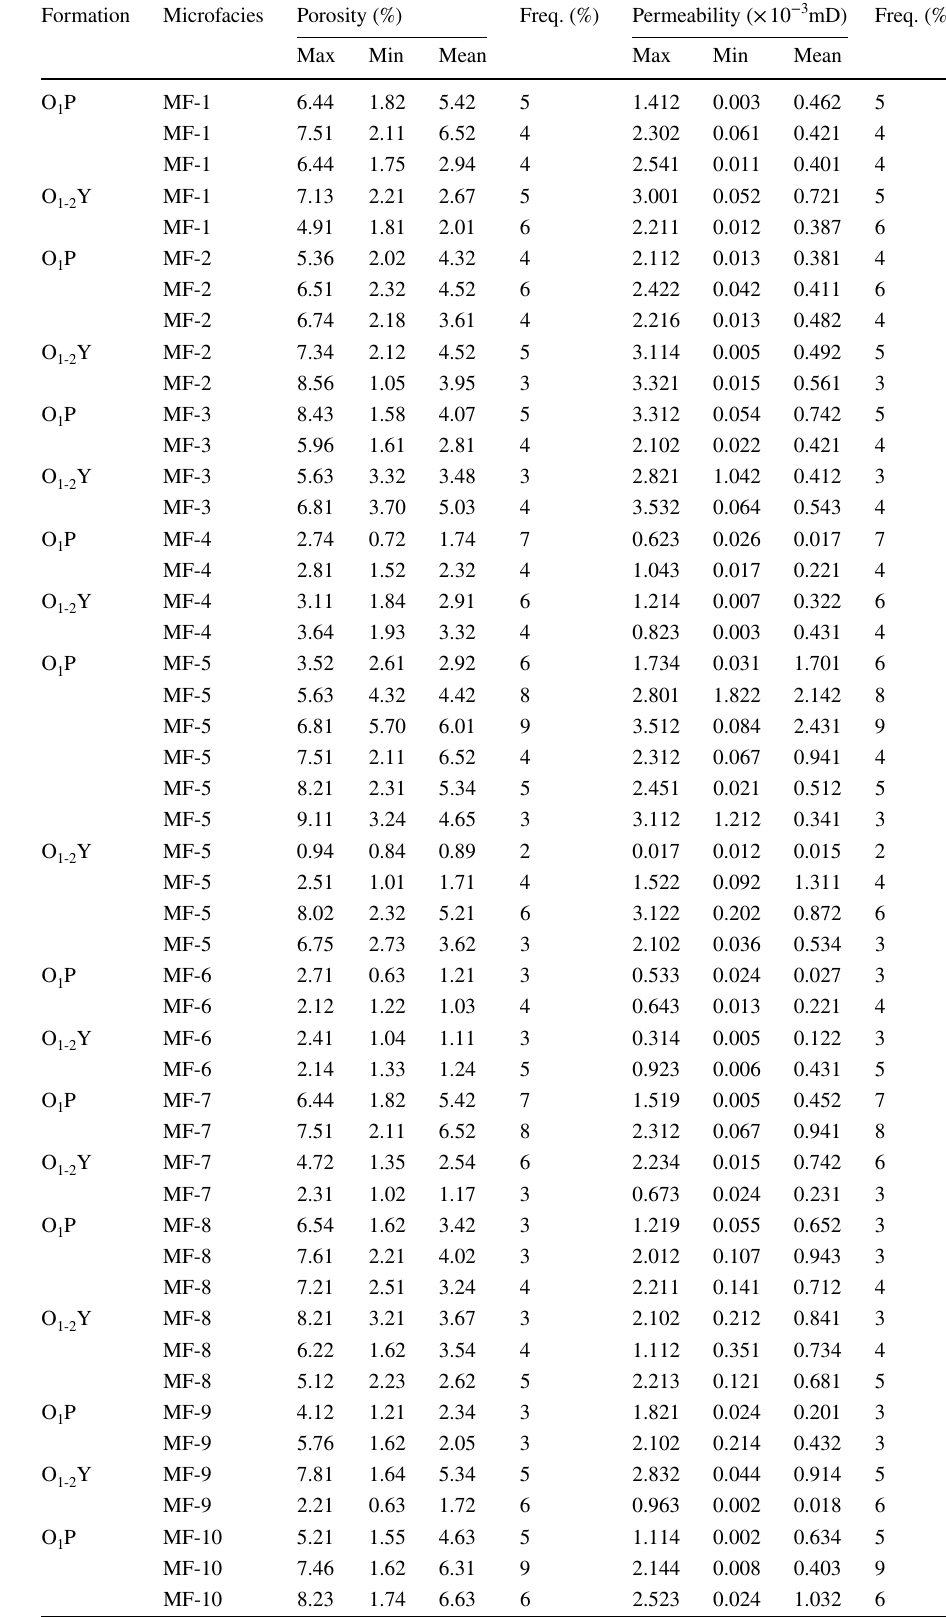
Table 2 Porosity and permeability data for the analyzed Lower Ordovician carbonate microfacies (MF-1 to MF-17) samples from the Tazhong Uplift in central Tarim